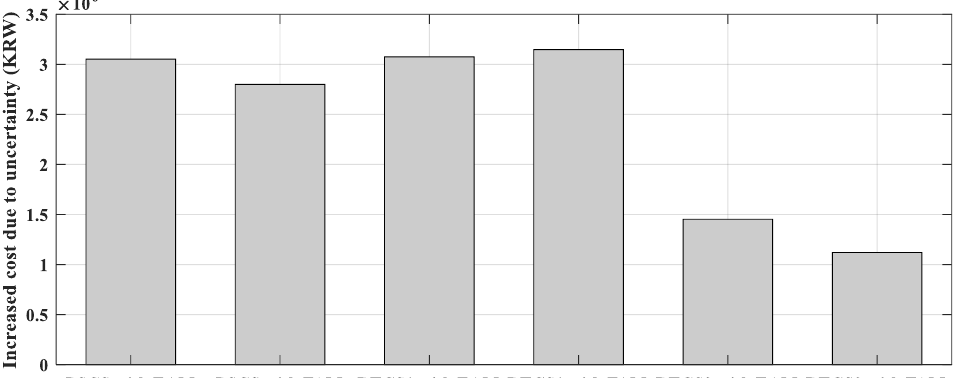
Figure 10. Comparison of increased operation cost due to forecast uncertainty.